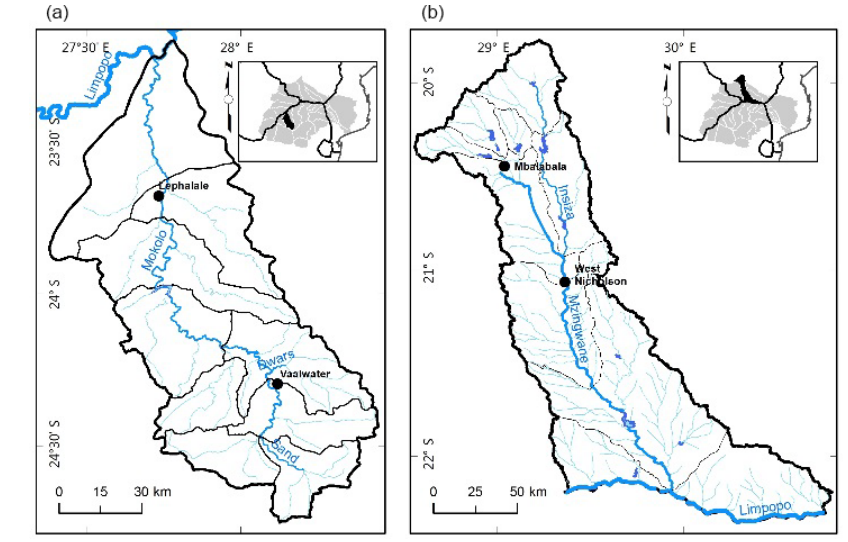
Figure 1. Map of the Mokolo (a) and Mzingwane (b) sub-basins and their locations in the Limpopo River